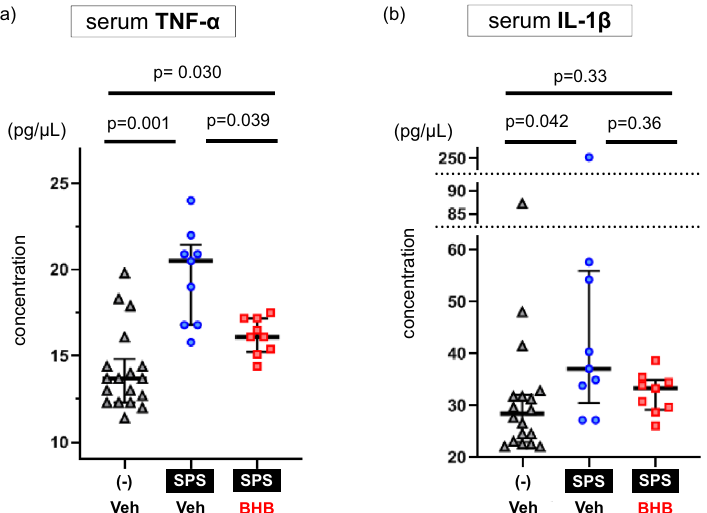
Figure 5. BHB reduces SPS-induced increase in serum inflammatory cytokine levels. ( a ) Serum TNF-α levels are shown (median [IQR]; non-SPS + Veh: 13.7 [12.4–14.4], SPS + Veh: 20.5 [16.8–20.9], SPS + BHB: 16.1 [15.4– 17.2], Kruskal–Wallis test; X2 = 17.265, df = 2, p = 0.0002). SPS exposure increased levels of TNF-α in the blood (Mann–Whitney’s U-test; W = 11, p = 0.001). Chronic BHB treatment decreased levels of TNF-α in the blood in SPS-induced PTSD rats (Mann–Whitney’s U-test; W = 69, p = 0.039). ( b ) Serum IL-1β levels are shown (median [IQR]; non-SPS + Veh: 28.5 [23.5–31.8], SPS + Veh: 37.1 [33.9–54.3], SPS + BHB: 33.4 [29.7–34.5], Kruskal– Wallis test; X2 = 7.503, df = 2, p = 0.024). SPS increased levels of blood IL-1β (Mann–Whitney’s U-test; W = 34, p = 0.042). Chronic BHB treatment did not significantly decreased levels of IL-1β in the blood of rats exposed to SPS (Mann–Whitney’s U-test; W = 49.5, p = 0.33). The data are presented as scatter plots with median and interquartile range. Kruskal–Wallis test and Mann–Whitney U tests were performed to compare each group. p-values were corrected by Bonferroni method. TNF-α: Tumor necrosis factor-alpha, IL-1β: Interleukin-1 beta, SPS: single prolonged stress, Veh: Vehicle (PBS), BHB: beta-hydroxybutyrate, n = 18 (non SPS + Veh group) or 9 (SPS + Veh group and SPS + BHB